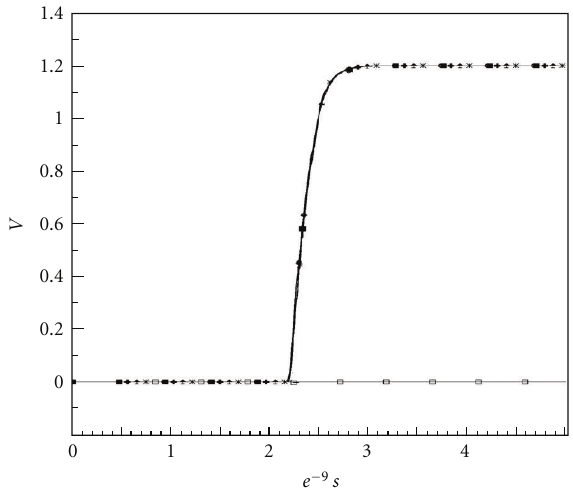
Figure 11: Outputs of the DES submodule block implemented on the secure